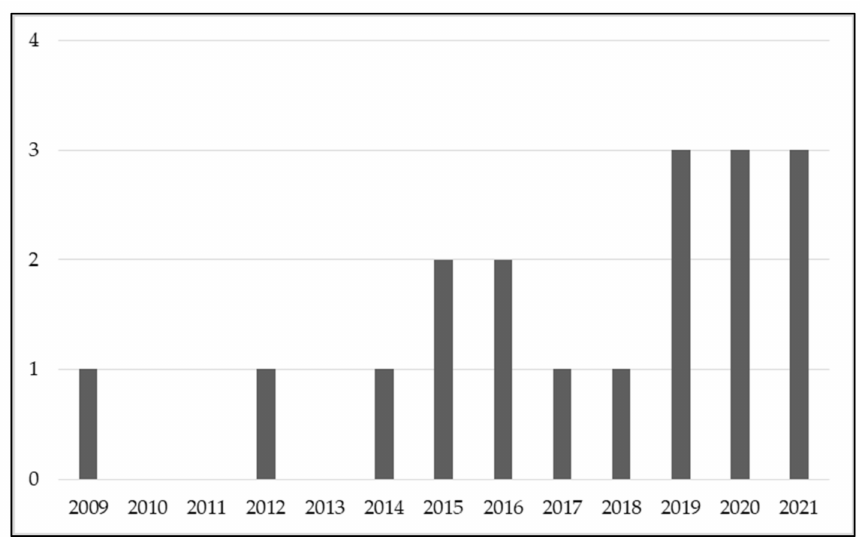
Figure 2. Number of articles investigating the determinants of energy efficient innovation, published per